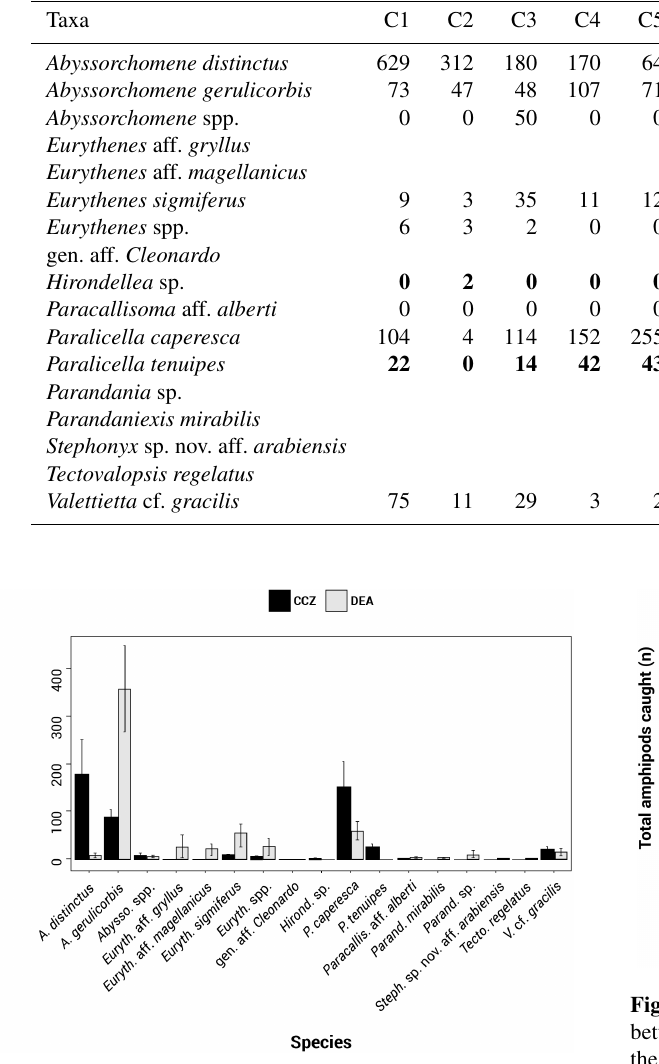
Figure 2. Histogram showing the species assemblage for the scav- enging community in the Clarion–Clipperton fracture zone (CCZ) (black) and the DisCOL experimental area (DEA) (grey). The abun- dances of 17 morphotypes are shown.